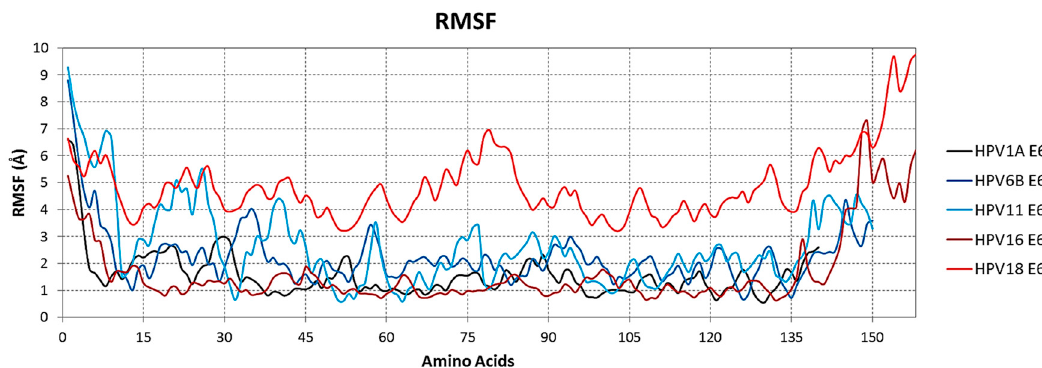
Figure 3. Structural variation of the disordered regions at the N- and C-termini of the proteins analyzed. Root mean square fluctuations (RMSF) values of C α atom coordinates during the simulation have been plotted to show the structural variation of the N- and C-termini of E6 proteins from HPV16, HPV18, HPV6B, HPV11, and HPV1A. It is observed that high-risk HPVs present greater structural variation at the C-terminal end. All graphs were generated using the Gnuplot 4.6 software [25].